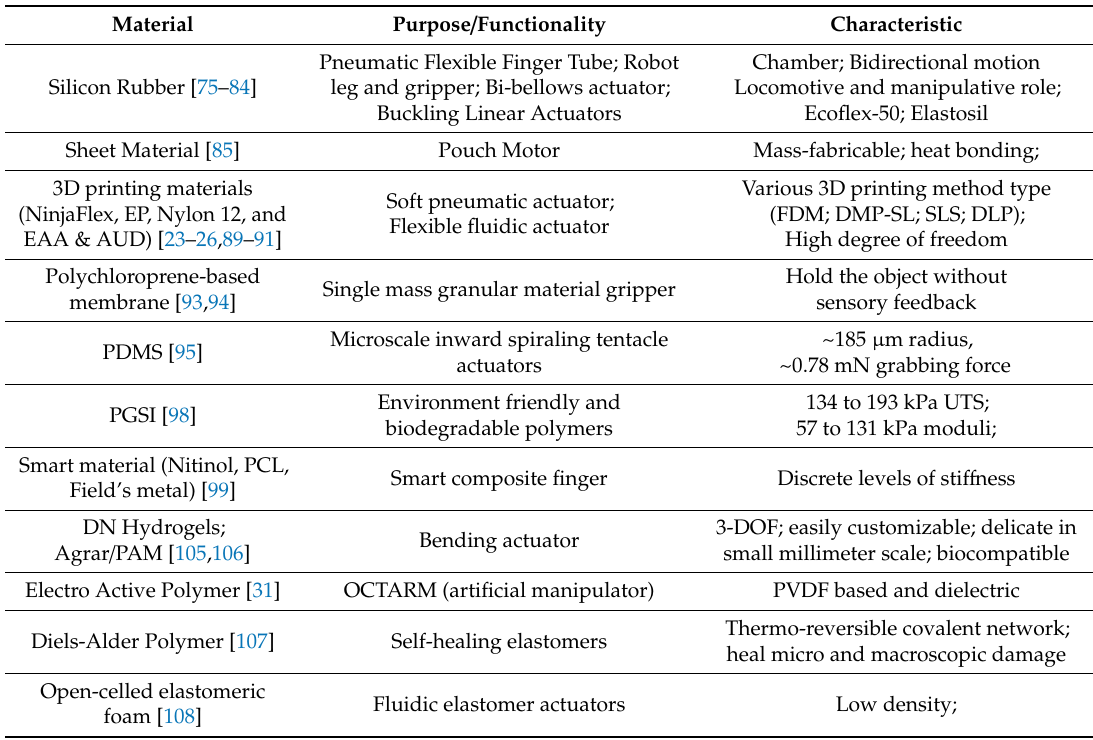
Table 2. Summary of Di ff erent Components of Testing for Soft Robotic